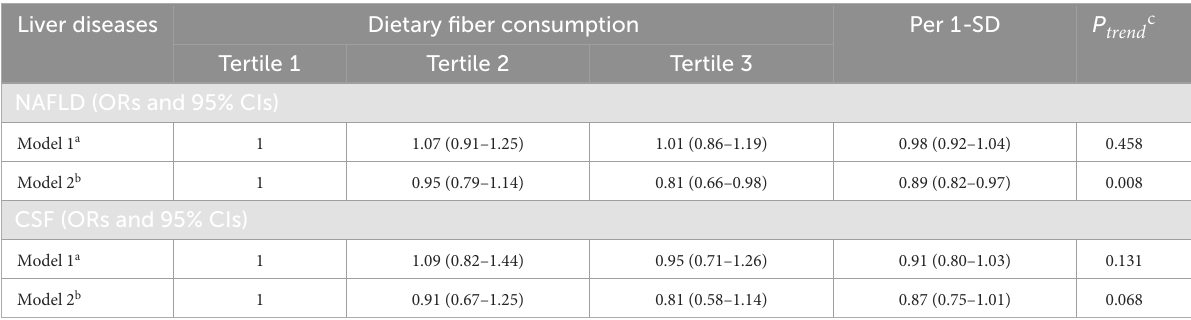
TABLE 2 The associations of dietary fiber consumption with NAFLD and CSF. Liver diseases